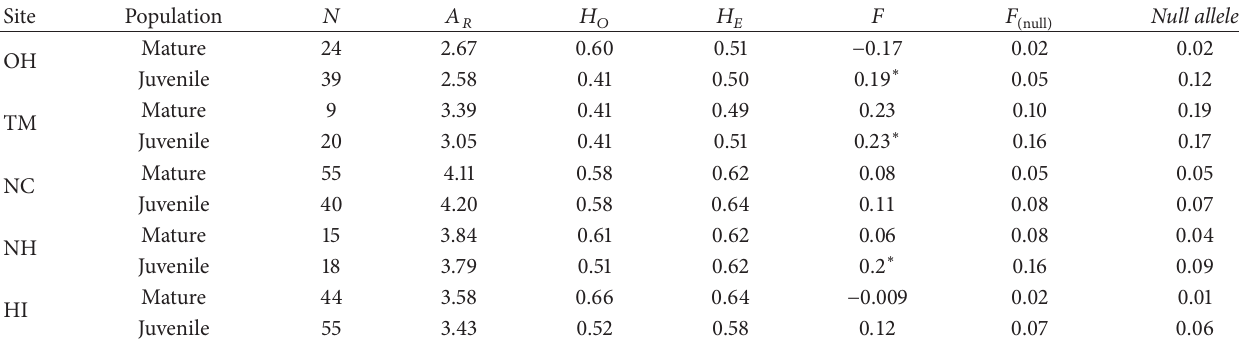
Table 2: Genetic diversity of five M. thunbergii populations around Lake Biwa.